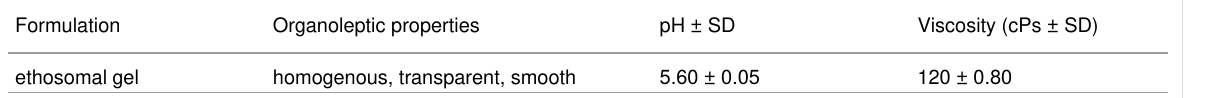
Table 2: Evaluation of ethosomal gel properties a